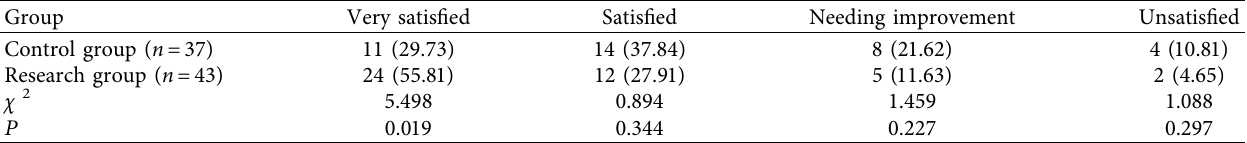
Table 4: Comparison of nursing